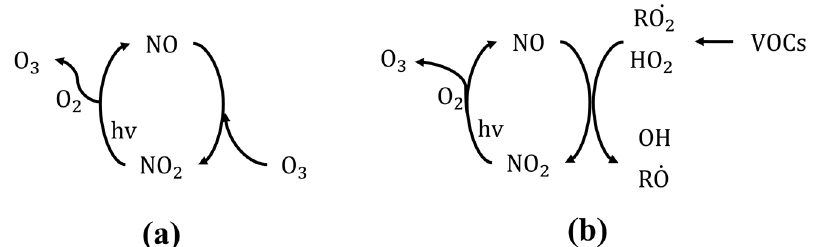
Figure 5. Schematics of the reactions involved in NO-to-NO 2 conversion and O 3 formation in ( a ) NO-NO 2 -O 3 systems in the absence of VOCs and in ( b ) NO-NO 2 -O 3 systems in the presence of VOCs.